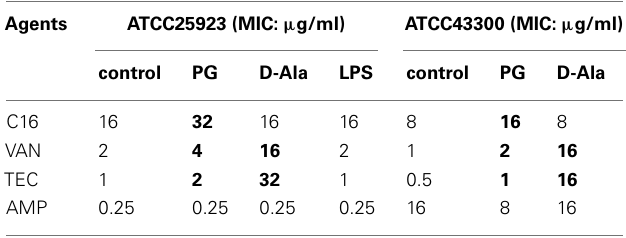
Table 6 | Effect of peptidoglycan, D-Ala-D-Ala, and lipopolysaccharide on antistaphylococcal activity of C16.